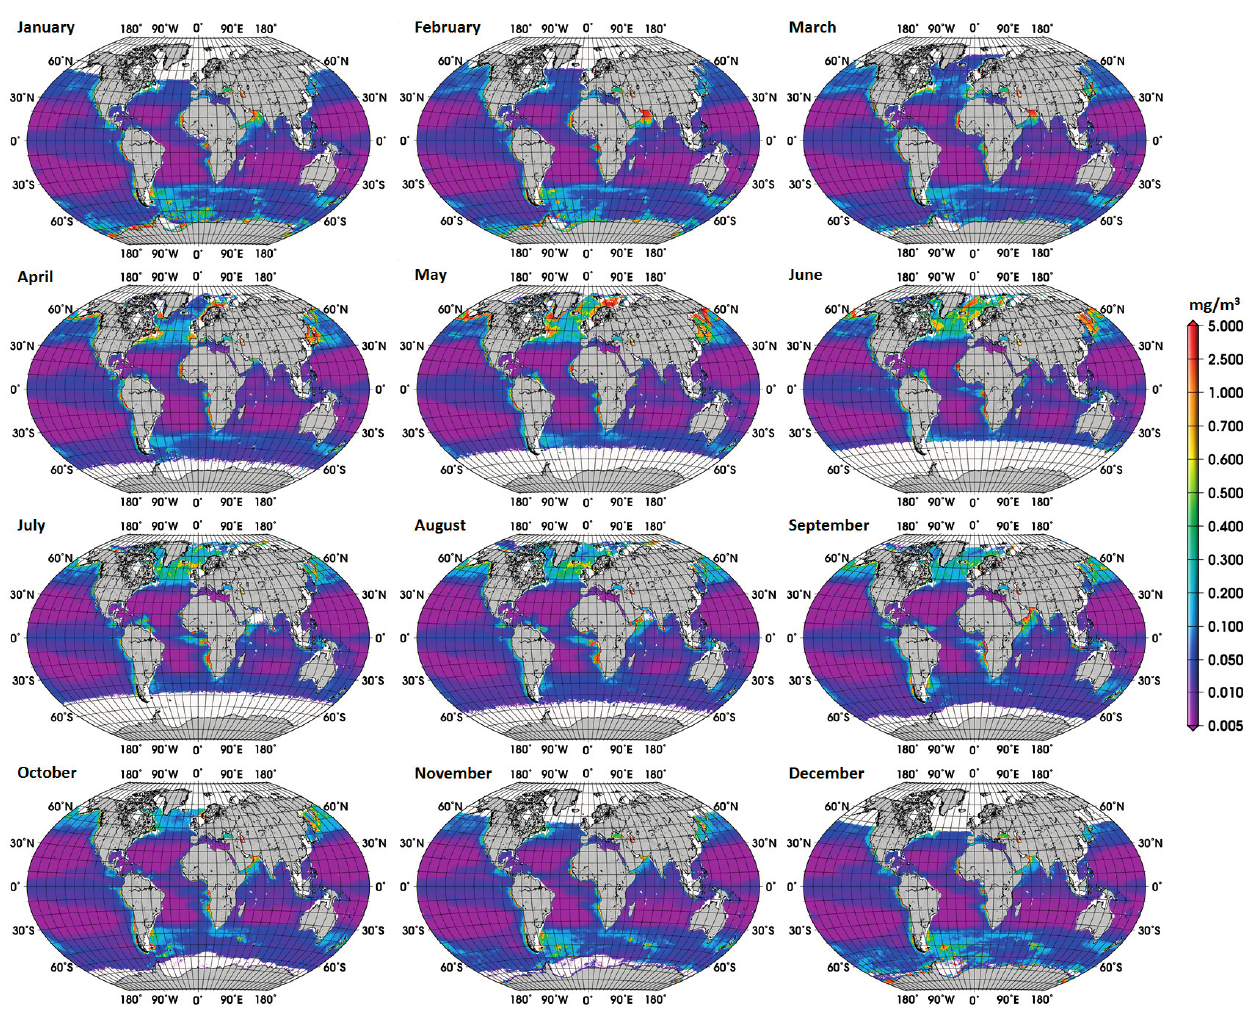
Figure 4. Climatology of TChla of diatoms (mg/m 3 ) for the months of January to Zpd model. White areas December based on the period 2003–2013 retrieved using the ABA Zpd correspond to waters with depths shallower than 200 m or without satellite